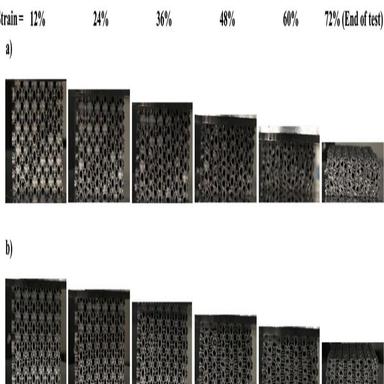
Images captured at different strains during the compression test of the heat-treated samples for the a) 10% and b) 19% relative density samples tested at room temperature.